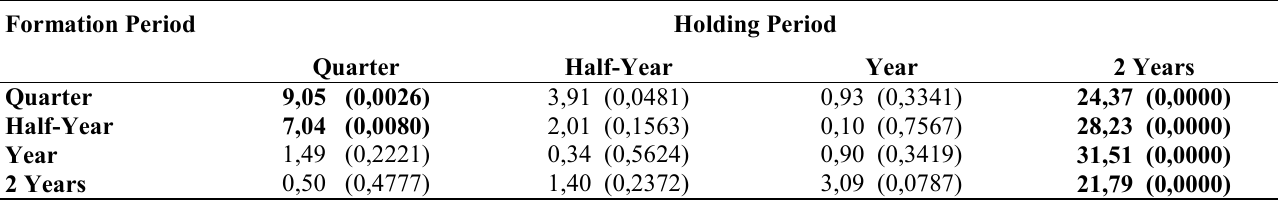
Table 6: Results of the bond summary tables for the different formation and holding periods using medians Formation